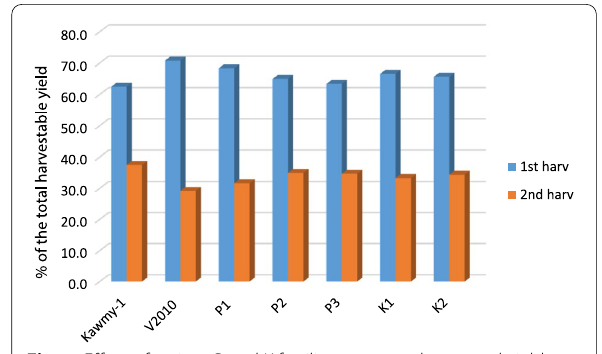
Fig. 1 Effect of variety, P and K fertilizer on mungbean seed yield percentage at the 1st, 2nd harvest of the total seed yield